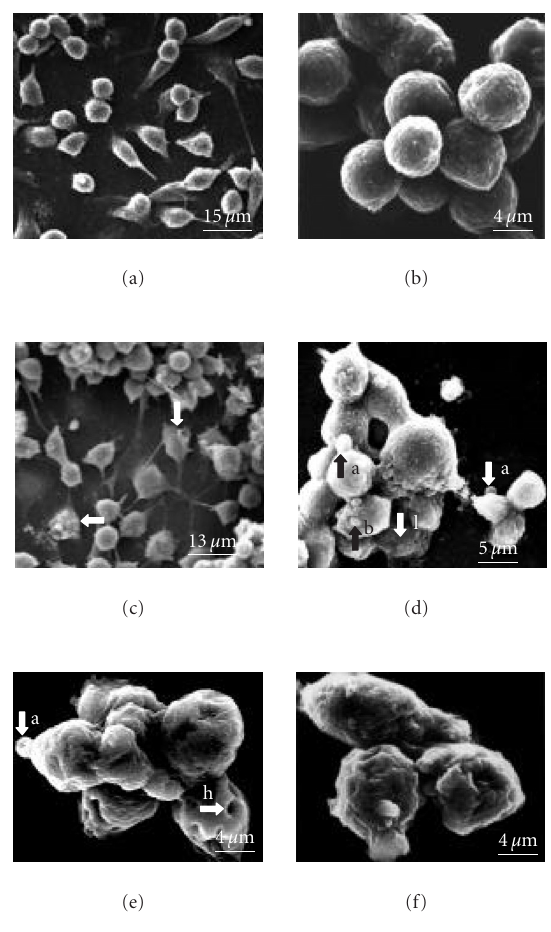
Figure 8. Scanning electron micrographs of untreated and 24-hour-treated 4T1 cells with anastrozole (50 µ g/mL), tamox- ifen citrate (5 µ g/mL), and the combination of the two drugs (50 µ g/mL and 5 µ g/mL). (a) Characteristics of untreated 24 hour culture showing rounded and flattened cells. (b) Normal surface characteristics of untreated clumped cells shown at 48 hour. (c) Twenty-four-hour anastrozole-treated 4T1 cells show- ing various surface abnormalities (arrows). (d) Enlarged view of 24-hour anastrozole-treated 4T1 cells depicting apoptotic bod- ies (a), blebs (b), and lysed cells (l). (e) Tamoxifen-treated cells at 24 hour depicting irregularly shaped cells with apoptotic bodies (a) and holes (h). (f) Anastrozole- and tamoxifen-treated cells. The irregularly shaped cells depict many surface ultrastructural changes including blebs and membrane